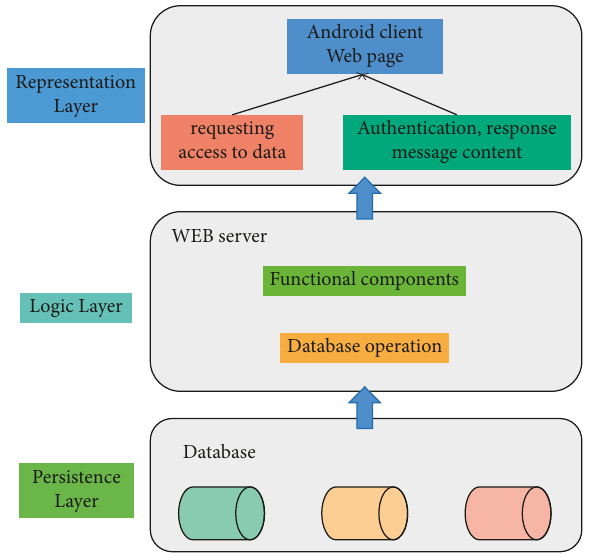
Figure 3: Overall system architecture diagram. Table 1: Experimental